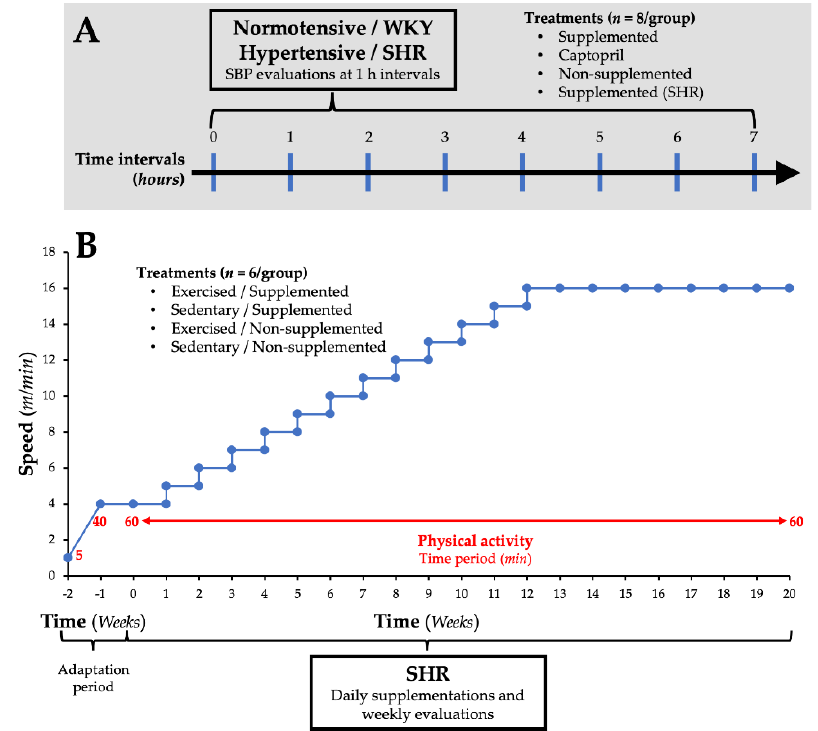
Figure 1. Scheme of interventions. Part ( A ): Evaluations of SBP in normotensive (WKY) and hypertensive (SHR) rats. WKY were randomly allocated into three groups, and an additional group of SHR was evaluated. All treatments were administered by gavage. Part ( B ): Evaluations of SBP in SHR. SHR were randomly allocated into four groups. Supplementations were carried out by gavage. Physical activity time period and intensity were gradually increased from 5 to 60 min and from 1 to 16 m / min, respectively. SBP: systolic blood pressure. WKY: Wistar Kyoto rats; SHR: spontaneously hypertensive rats.